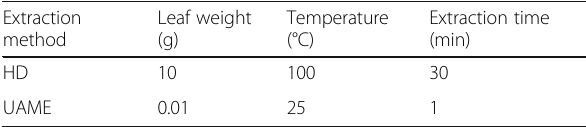
Table 2 Comparison of extraction conditions between hydrodistillation (HD) and ultrasound-assisted microextraction